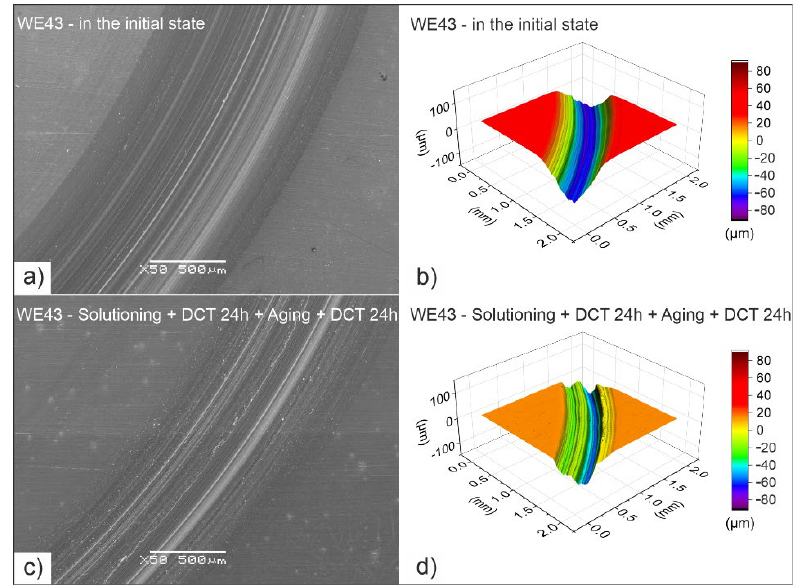
Figure 8. SEM microscope images and isometric 3D images of wear traces of WE43 magnesium alloy in the initial state ( a , b ) and after deep cryogenic treatment combined with precipitation hardening ( c , d ).